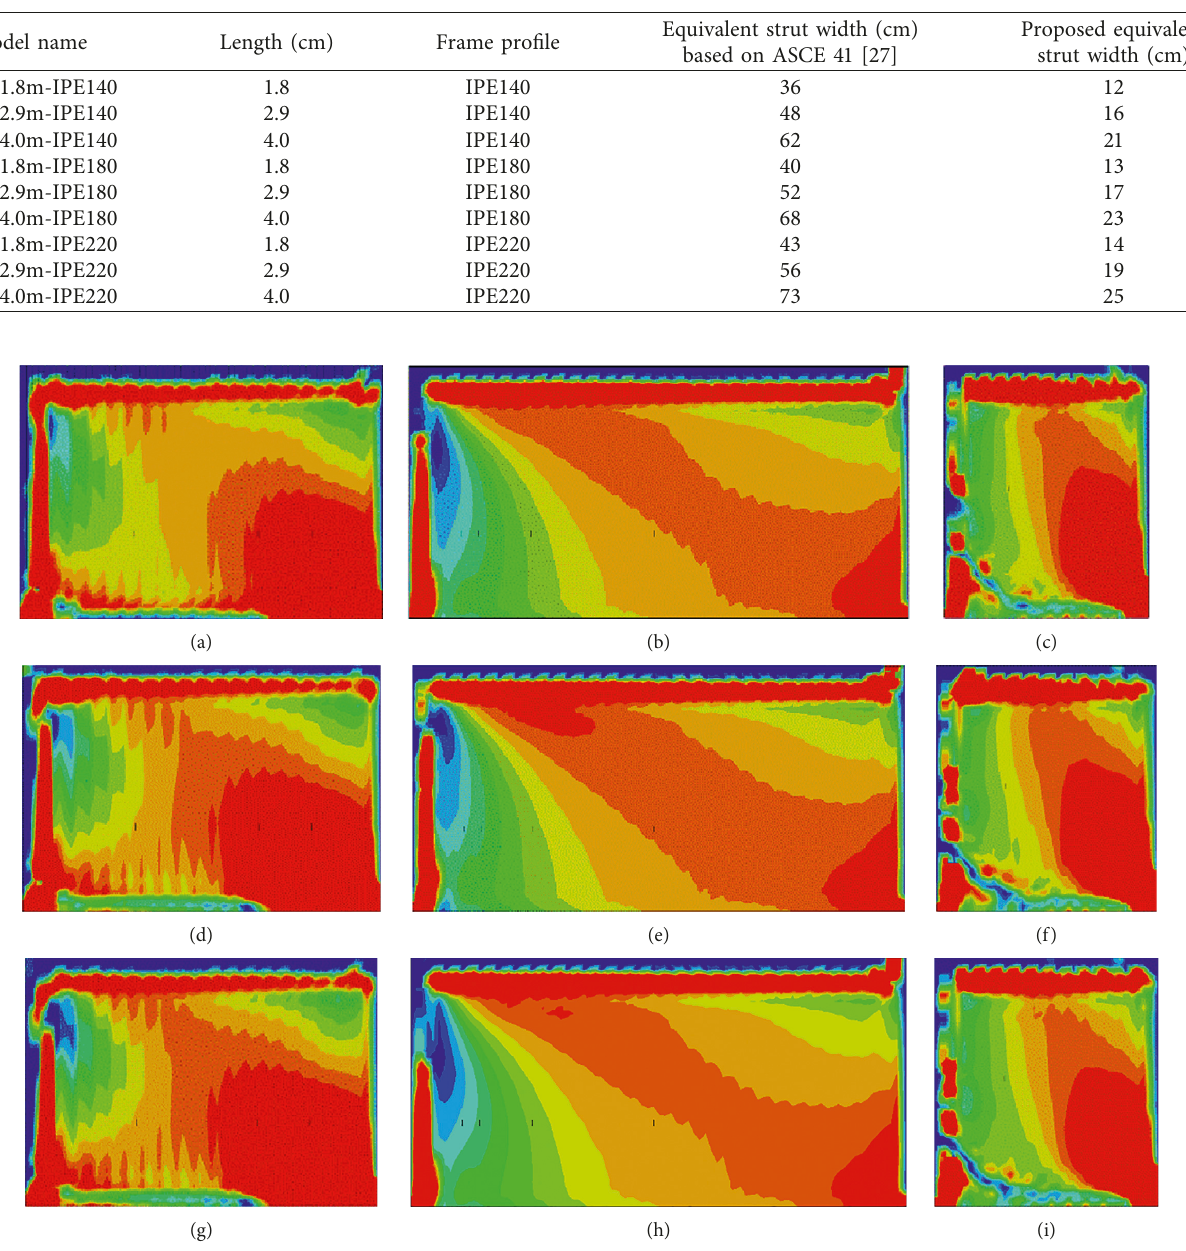
Figure 10: Formation of the compressive struts. (a) M-1.8m-IPE140. (b) M-2.9m-IPE140. (c) M-4.0m-IPE140. (d) M-1.8m-IPE180. (e)